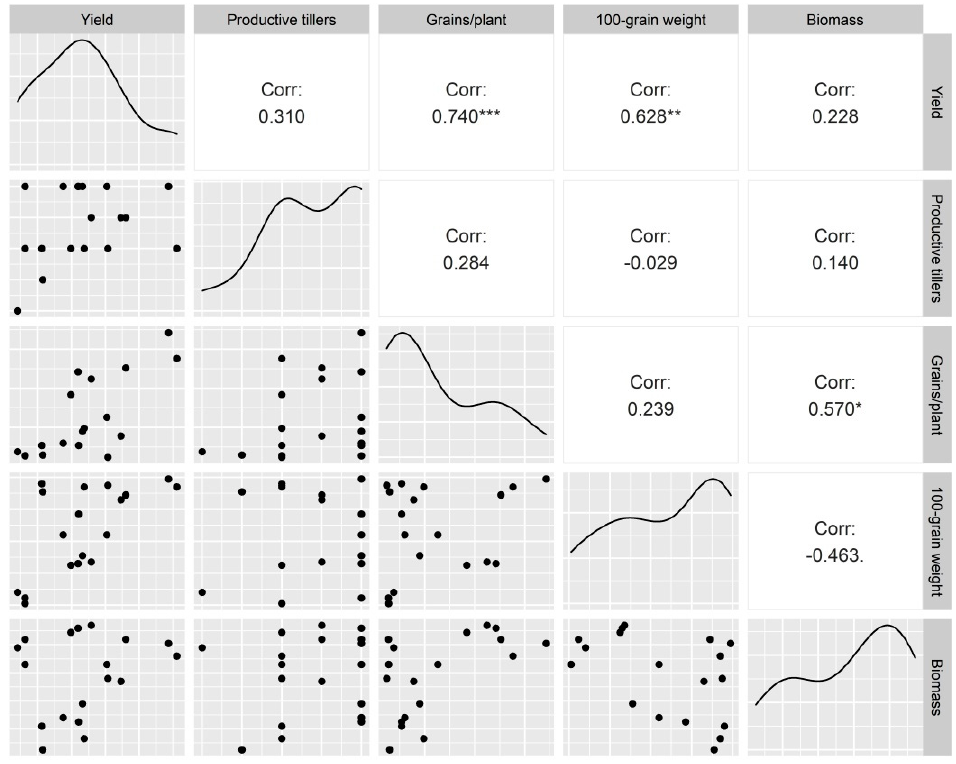
Figure 6. Correlation of growth and yield components at harvest. * Significantly different at p < 0.05; ** significantly different at p < 0.01; *** significantly different at p < 0.001.